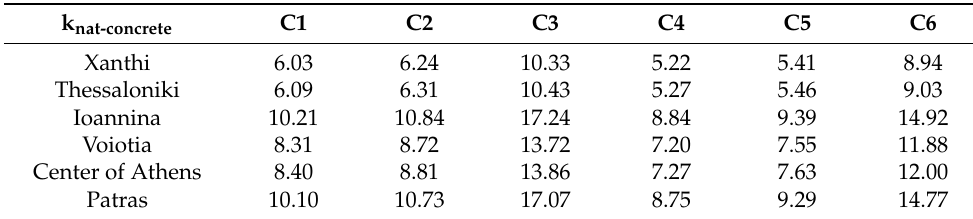
Table 27. Prediction of k coefficients of all concretes for all selected areas.